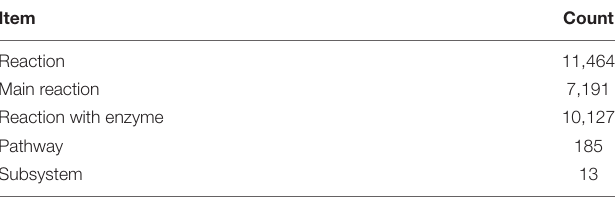
TABLE 1 | Information collected from KEGG